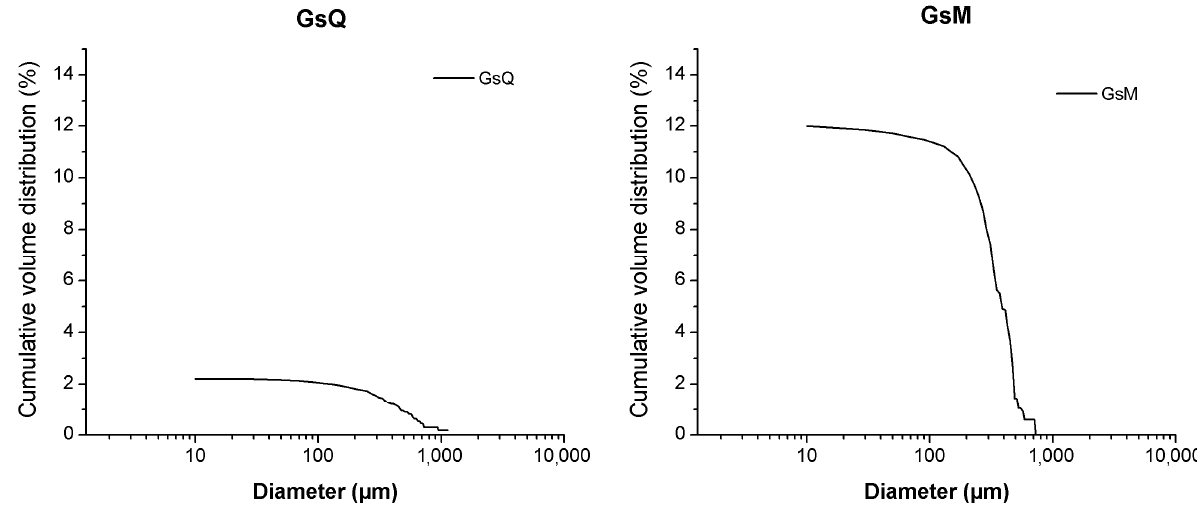
Figure 10. Cumulative porosity distribution of GsQ ( left ) and GsM ( right ) samples analyzed with computed X-ray to- mography.